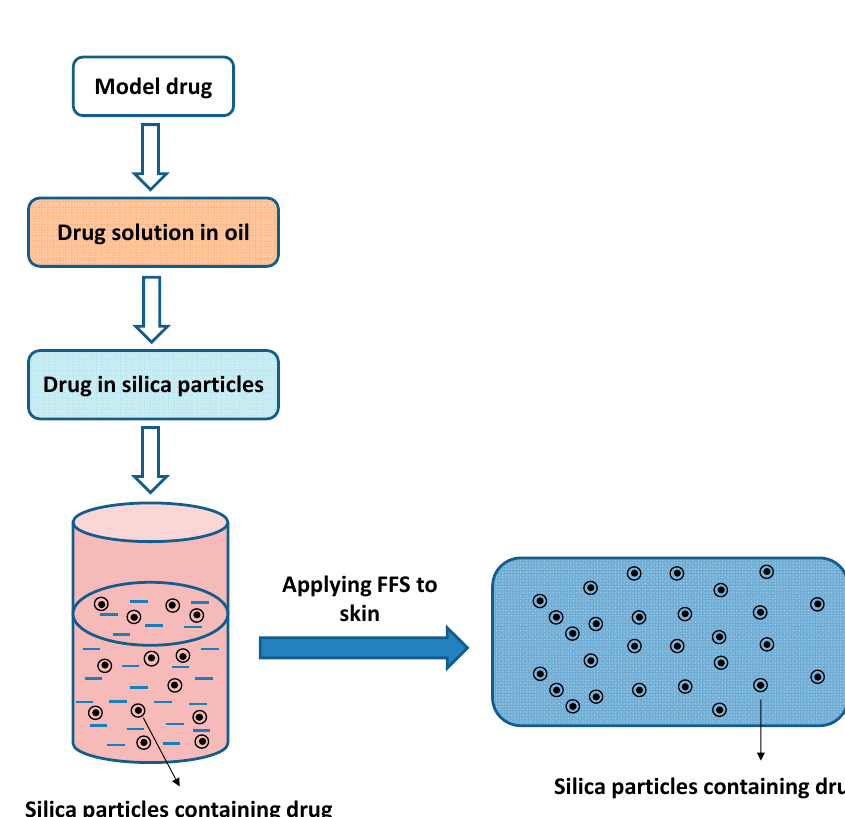
Figure 4. Illustration of a film-forming system containing particles for controlled drug release [58,71].